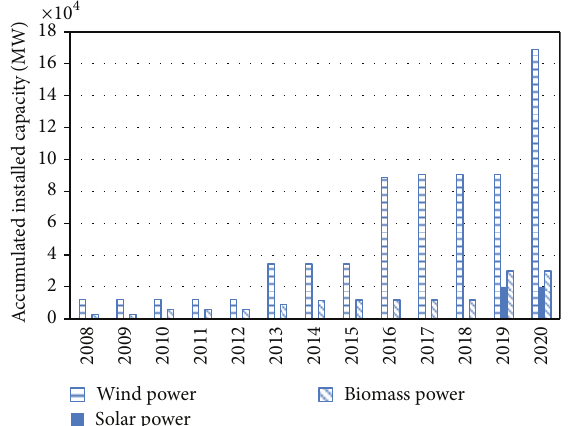
Figure 2: The accumulated installed capacities of three renewable sources of power.